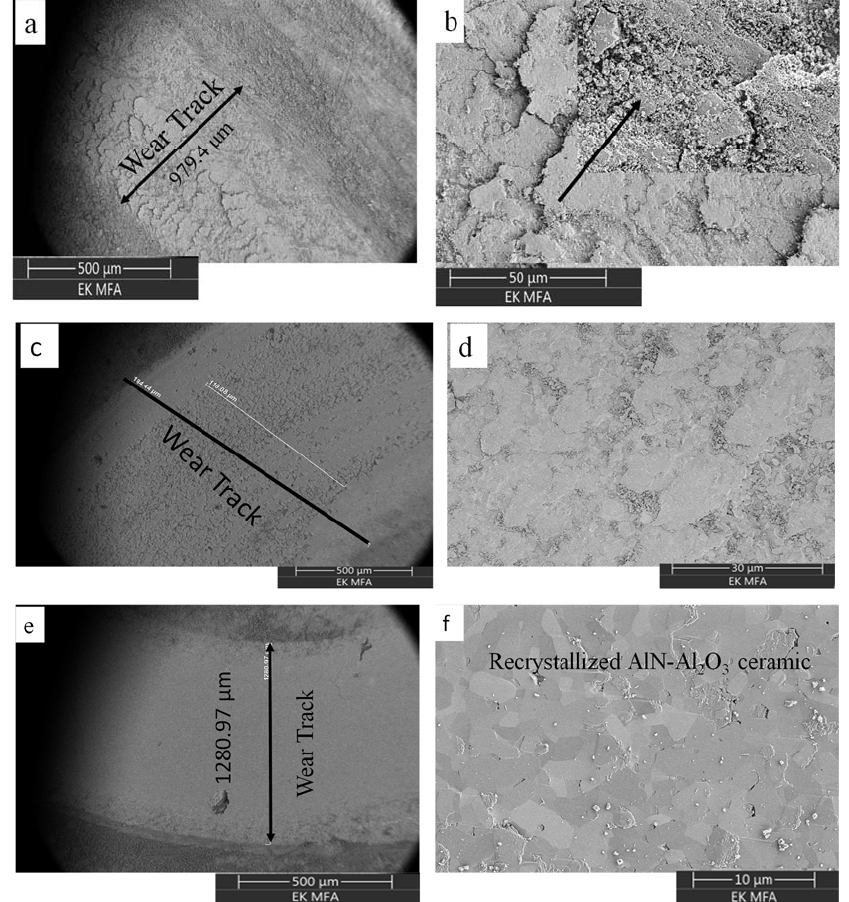
Figure 8. SEM micrographs of the wear track after the tribology tests. The ( a , b ) after 3 h oxidation time—S3, ( c , d ) after 10 h oxidation time—S10, ( e , f ) after 20 h oxidation time—S20 and respectively. We also see Al 2 O 3 oxide clusters at the surface of the wear track in the inset of ( b ) and the recrystallized AlN ‐ Al 2 O 3 dual composite at the surface of ( f ). The wear track width was measured using optical microscopy, the wear parameters like wear rate and wear factor (Equations (2) and (3)) were calculated and tabulated, Table 2. The constant parameters required for calculations are radius of the track R—3.5 mm,